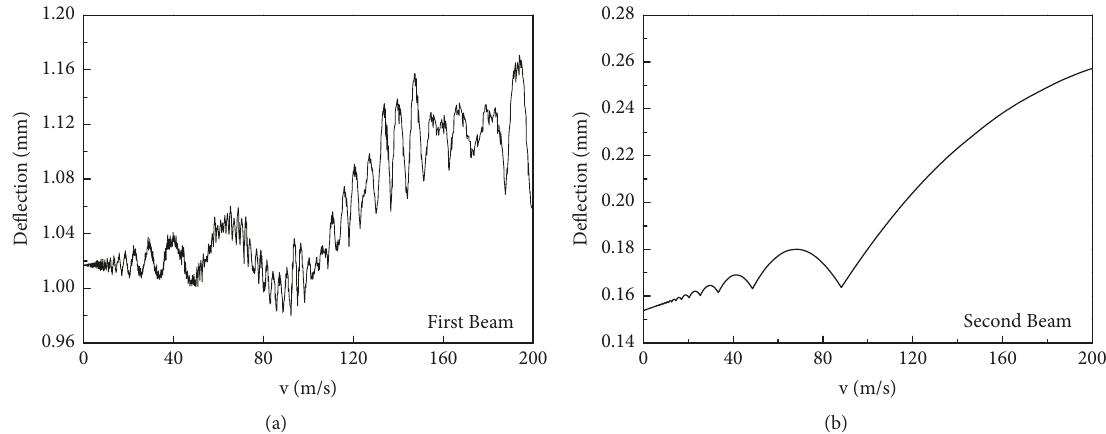
Figure 7: Relationship between maximum deflection and loading speed for mid-span of double simply supported beam: (a) first beam; (b) second